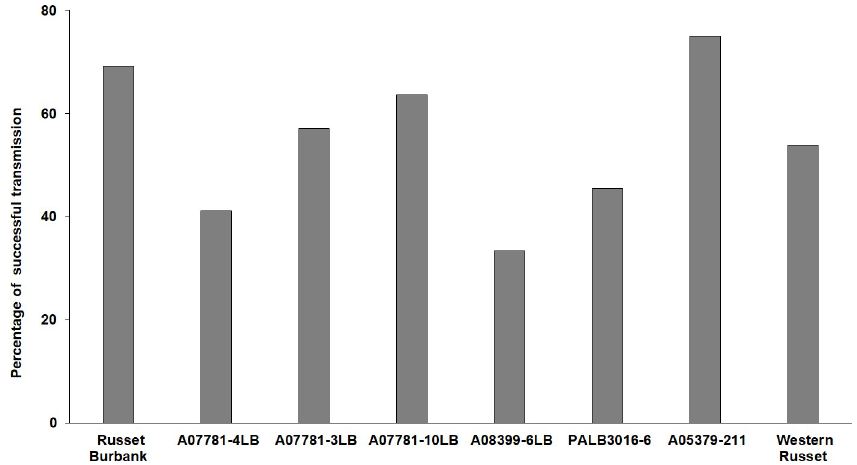
Fig 1. Percentage of plants infected with “ Candidatus Liberibacter solanacearum” after inoculation with Lso- positive potato psyllids. The experiment was conducted in 2016 and Lso infection was confirmed by testing fresh tubers of each genotype.